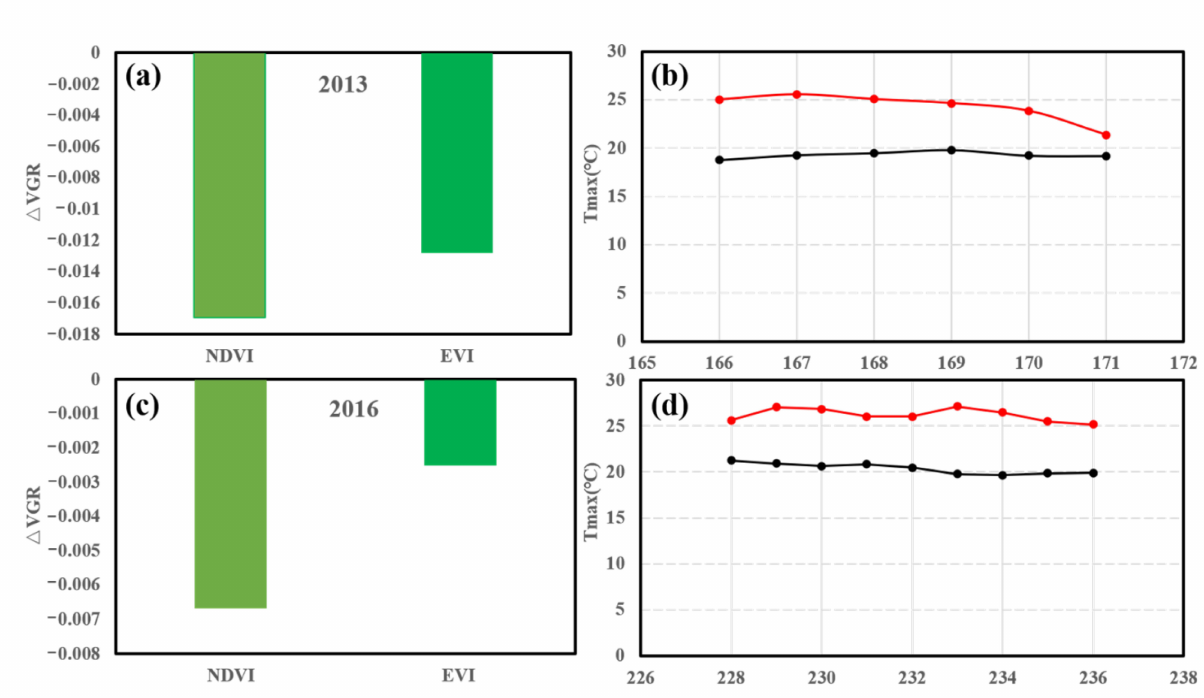
Figure 9. The ∆ VGR and daily maximum temperatures during the heatwaves in June 2013 and August 2016. ( a , c ) represent the ∆ VGR in June 2013 and August 2016, respectively; ( b , d ) represent the average daily maximum temperature (T max ) versus the multi-year average T max during the heatwave occurrence in June 2013 ( b ) and August 2016 ( d ). The red line indicates the T max (15 June 2013– 20 June 2013 DOY: 166–171 and 16 August 2016–24 August 2016 DOY: 228–236) during a heatwave in one severe year. The black line indicates the multi-year average T max during heatwaves occurrence in June 2013 and August